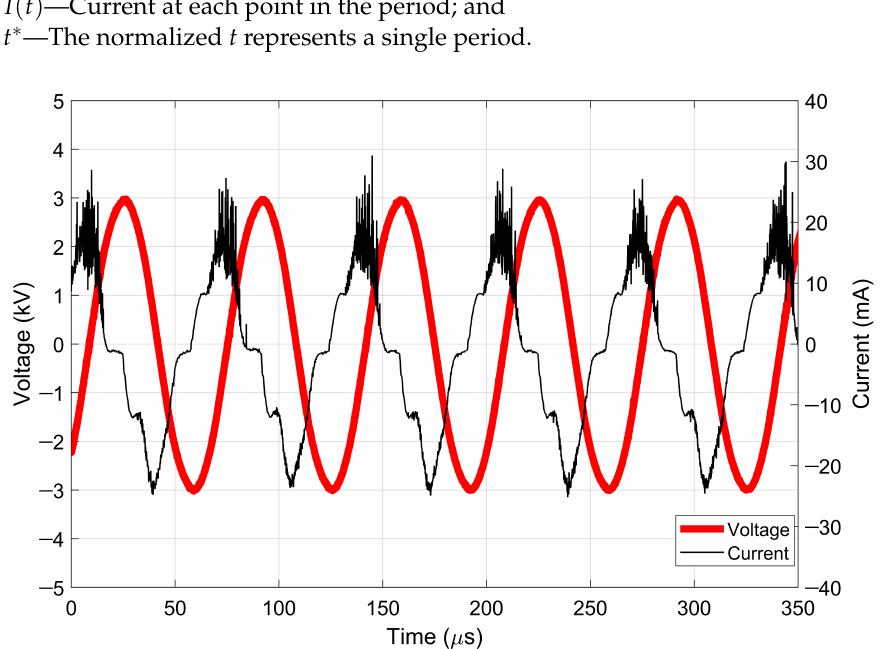
Figure 17. Voltage and current applied to a Plasma Actuator used in the experiments, where duty = 1. The mechanical power of the plasma actuator can be calculated based on the velocity profile of a single PA, operating with duty = 1, no free stream flow, and no external force, using Equation (5). Under these conditions, the momentum should theoretically be conserved in all velocity profiles. The plasma actuator velocity profile at x = 60 mm (Figure 18) was used to calculate the PA mechanical power.